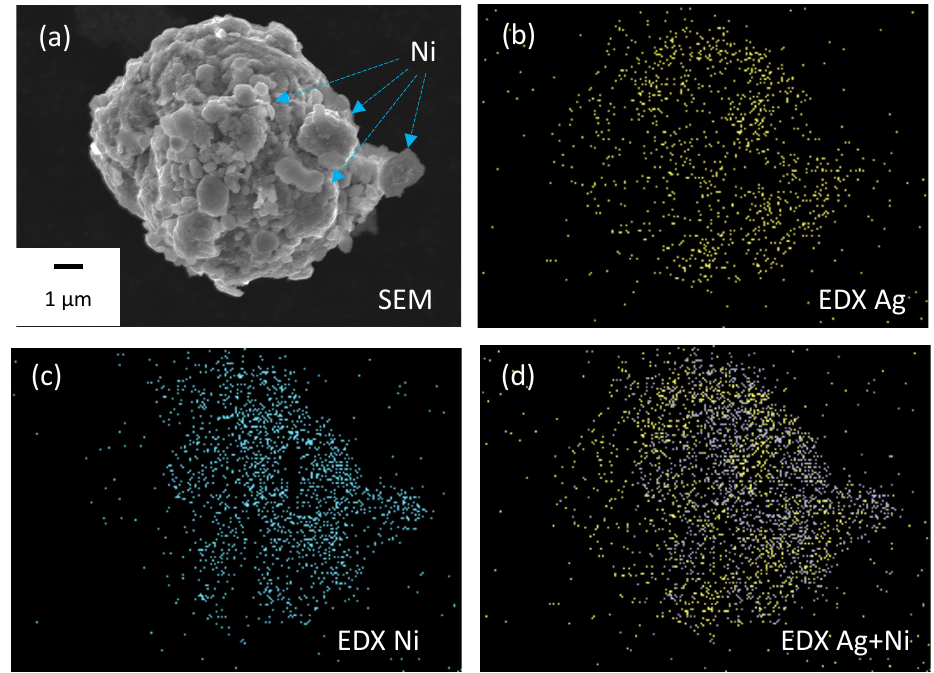
Figure 2. ( a ) Scanning electron microscopy (SEM) image of a Ag–Ni composite toner particle. ( b ) Energy dispersive X-ray spectroscopy (EDX) image of the Ag K α X-ray emission distribution, EDX image of the Ni K α X-ray emission distribution ( c ), and superimposed EDX image of the Ag and Ni EDX K α emission ( d